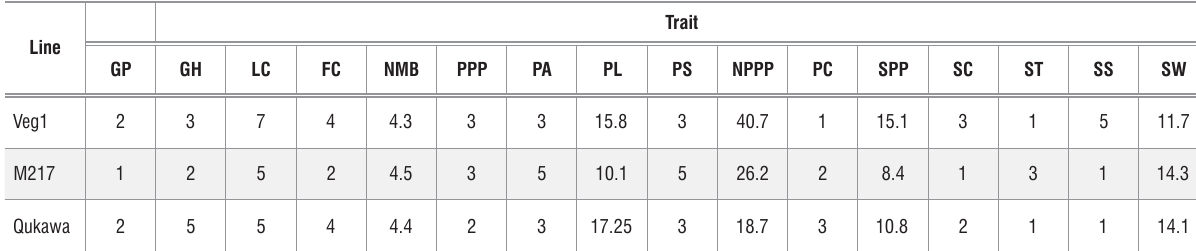
Qualitative and quantitative traits of the three cowpea